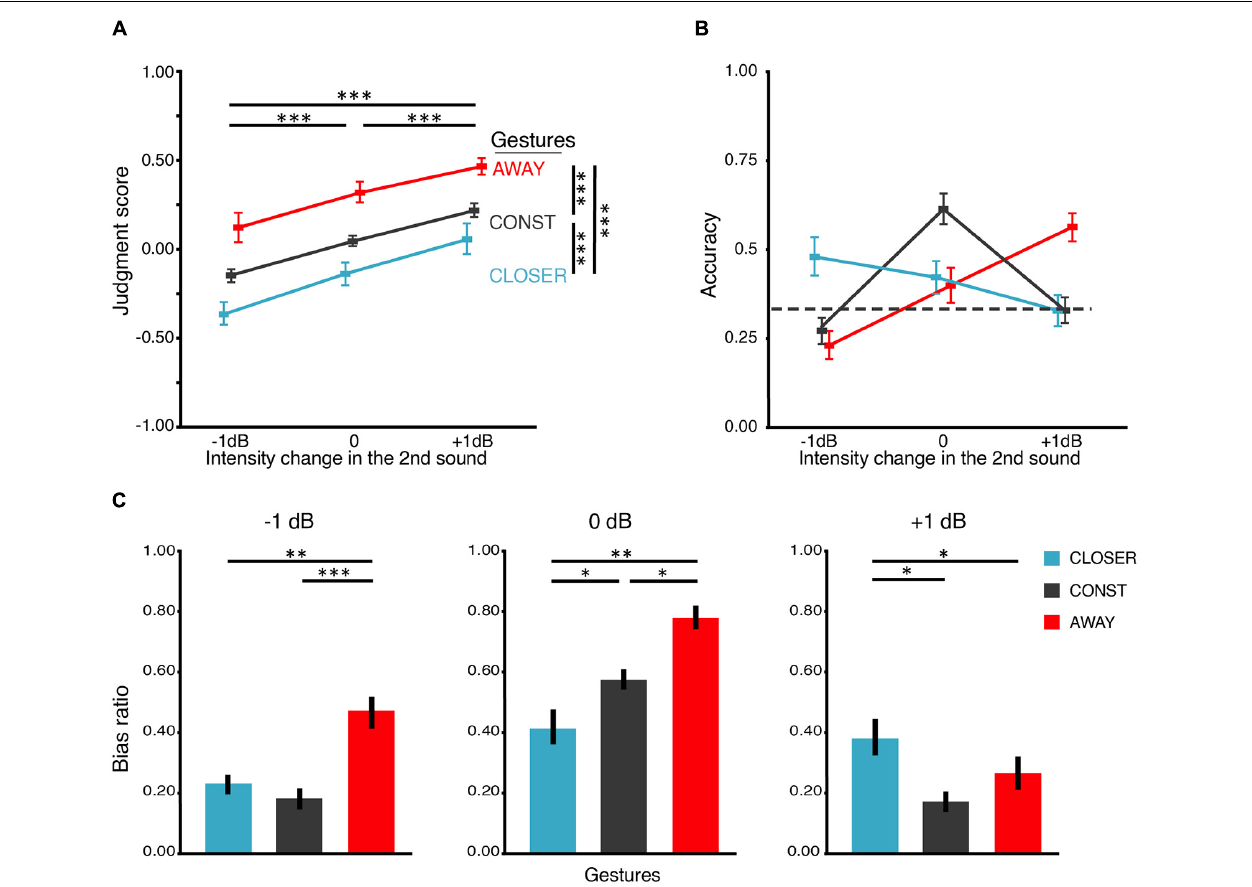
FIGURE 2 | Results of BE1. (A) Judgment score. BE1 investigated how motional gestures influenced loudness perception. The judgment score was obtained by averaging all the responses in which “1” for “louder,” “0” for unchanged, and “–1” for softer. Therefore, the judgment score reflects the overall judgment tendency, where 0 stands for no change, positive for louder and negative for softer. Participants can correctly identify the intensity changes – the judgment scores increased as the intensity increased in all gesture conditions. Moreover, gesture modulated the loudness judgment – in all levels of intensity change. Judgment scores in the AWAY gesture condition were larger than those in CONST, and judgment scores in CONST were larger than those in CLOSER. (B) Accuracy of the behavioral judgments about intensity change. We obtained accuracy by calculating the portion of trials that participants correctly identified the intensity change. There is an interaction between the factors of gesture and intensity change. The interaction was driven by higher accuracies in conditions where the changes in intensity and gestures were consistent. The dashed line indicates the chance level (0.33). (C) Bias ratios. The bias ratio was calculated to index how the manual gestures influence the loudness judgment to different intensity changes. For –1 dB intensity change (left panel) and 0 dB intensity change (middle panel), the judgment bias of louder percepts was obtained for each gesture: bias ratio = frequency of louder bias/frequency of all bias. For +1 dB intensity change (right panel), the judgment bias of softer percept was calculated for each gesture: bias ratio = frequency of softer bias/frequency of all bias. The results indicate that the judgment was biased toward the “matched” gesture in all intensity changes. All error bars indicate ± one SEM. ∗ p < 0.05; ∗∗ p < 0.01; ∗∗∗ p <